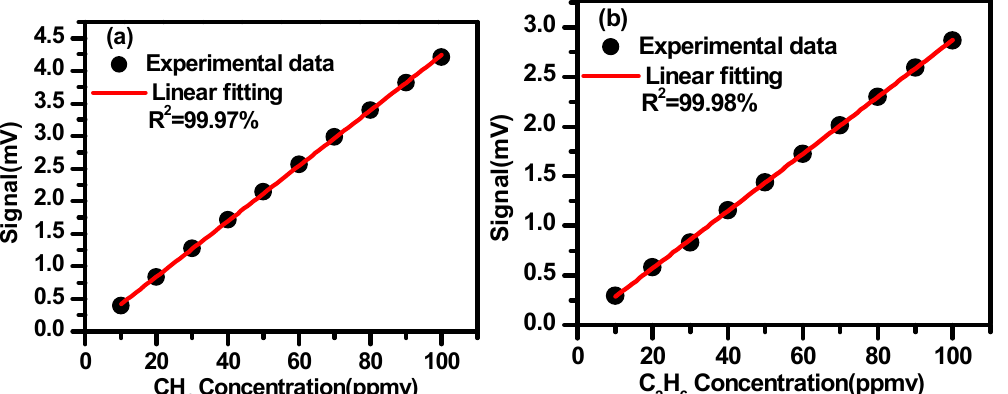
Figure 13. 2f signal amplitudes vs. gas concentrations of CH 4 ( a ) and C 2 H 6 ( b ).